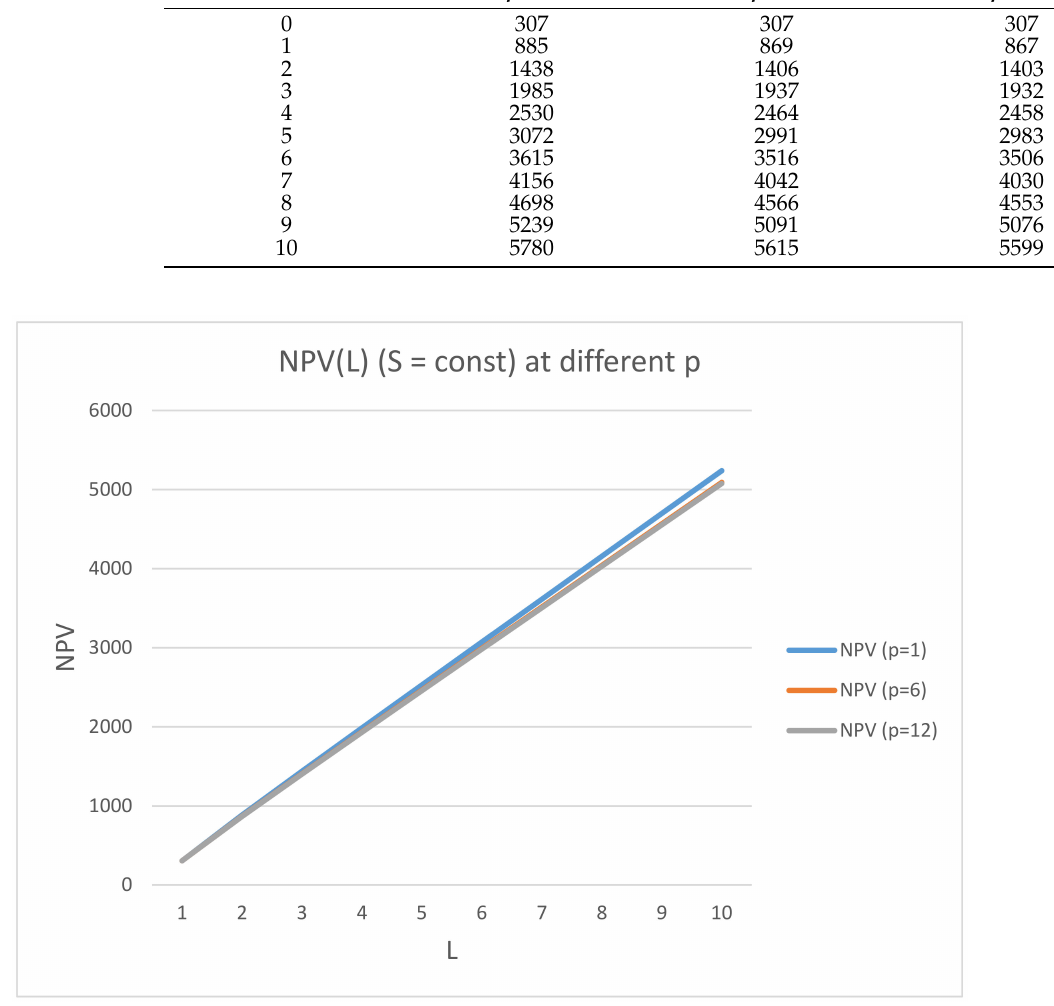
Figure 8. Dependence of NPV on leverage level L at k 0 = 0.22, k d = 0.14 and different p = 1, 6, 12 for a three-year